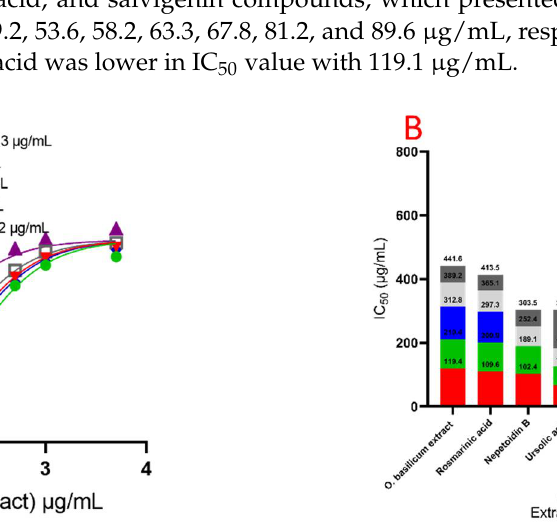
Figure 4. IC 50 of O. basilicum extract from cell suspensions and rosmarinic acid, nepetoidin B, ursolic acid, salvigenin, quercetin-3-O-rutinoside, rosmarinyl glucoside, isocitric acid, and chicoric acid against total proteases, trypsin-like serine proteinase, chymotrypsin-like serine proteinase, elastase, cysteine protease, and metalloprotease (in vivo) of R. ferrugineus midgut. ( A ) activity, with IC 50 of O. basilicum extract against proteases enzymes (in vivo), and ( B ) IC 50 of O. basilicum extract and compounds aganist proteases enzymes (in vivo), according to one-way analysis of variance on the enzyme activity data (ANOVA).